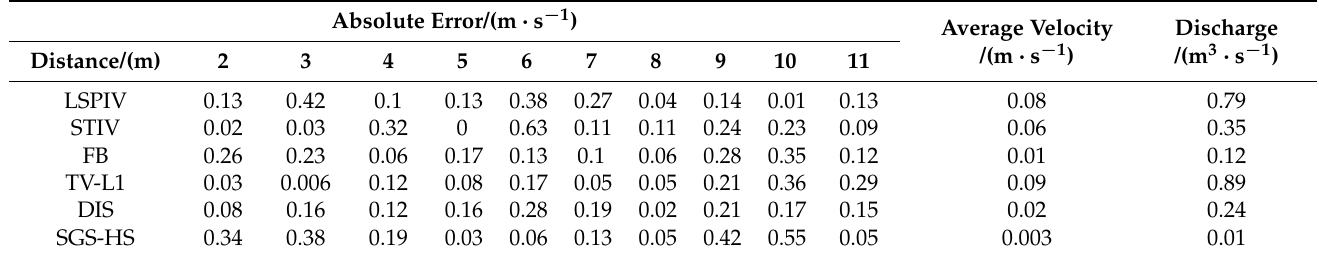
Table 3. Absolute errors of the velocity measurement results of the six algorithms.